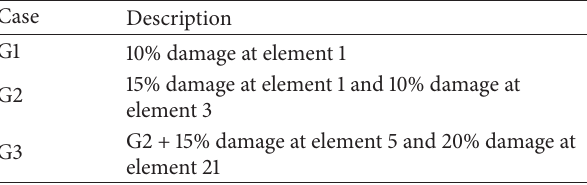
Table 7: Damage conditions to study damage detection in plane frame.